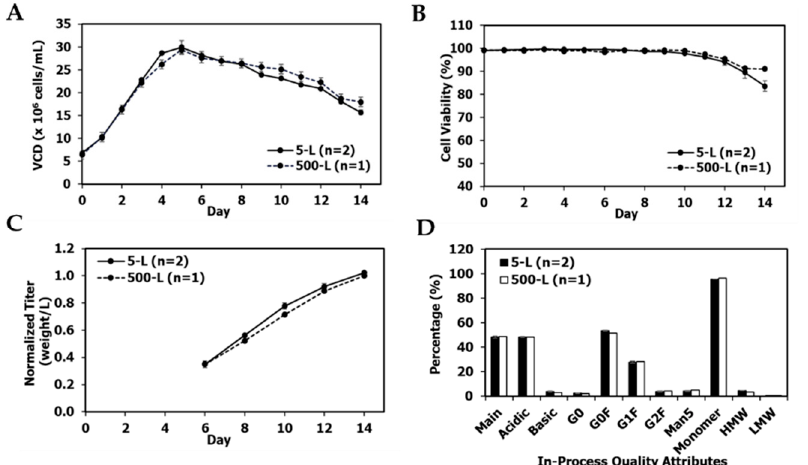
Figure 4. mAb1 re-clone production 500-L and 5-L satellite bioreactor culture performance, and quality attributes. ( A ) Production bioreactor VCD, ( B ) production viability, ( C ) normalized titer relative to 500-L day 14 titer, ( D ) in-process quality attribute profiles on day 14 at harvest. The values are reported as average ± difference/2 (n = 2).